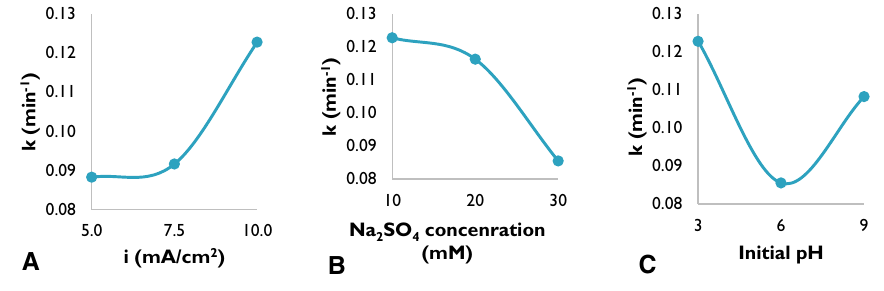
Fig. 3 Variation of reaction rate constant with the current den- sity (A), supporting electrolyte concentration (B) and the initial pH